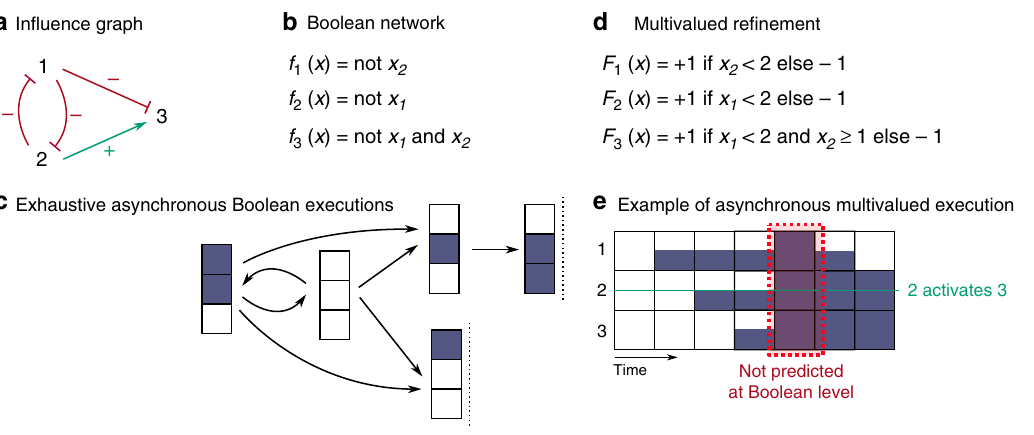
Fig. 2 Example of qualitative models for the interactions between three components. a In fl uence graph denoting the activation and inhibition relationships. b Example of a compatible BN, which de fi nes the activation conditions of each component. c Exhaustive list of transitions obtained from the initial con fi guration where all three components are inactive. d Example of a multivalued network re fi ning the BN ( b ) with components able to exist under three states (0, 1, 2). e Example of asynchronous execution of the multivalued network from the con fi guration 000. Half and fully blue squares represent the states 1